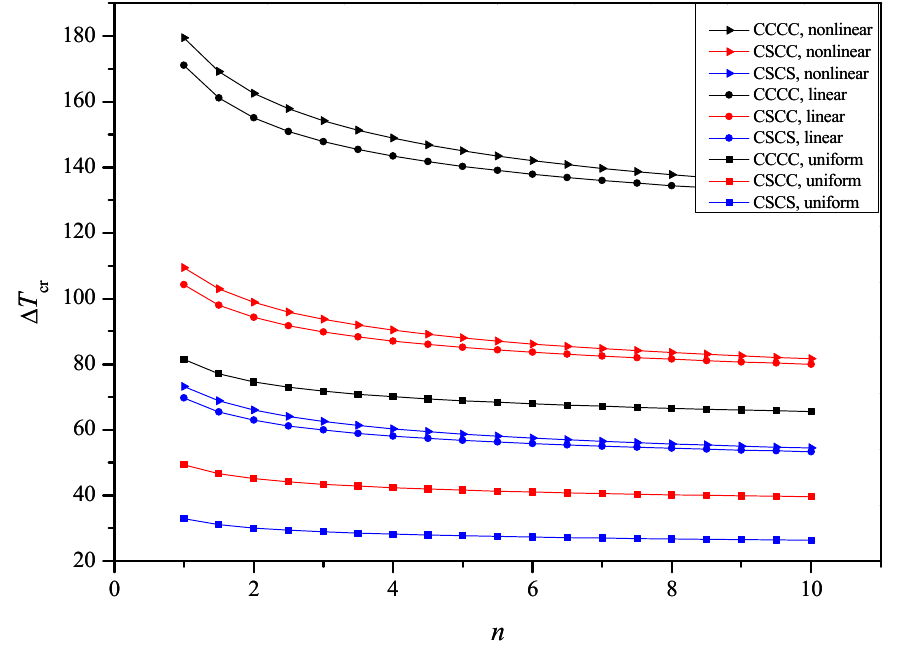
Figure 4. The relation between the critical buckling temperature ∆ T cr and power law index n of type-I FGM rectangular thin plate ( a / h = 100, a / b = 2, T 0 = 300 K).